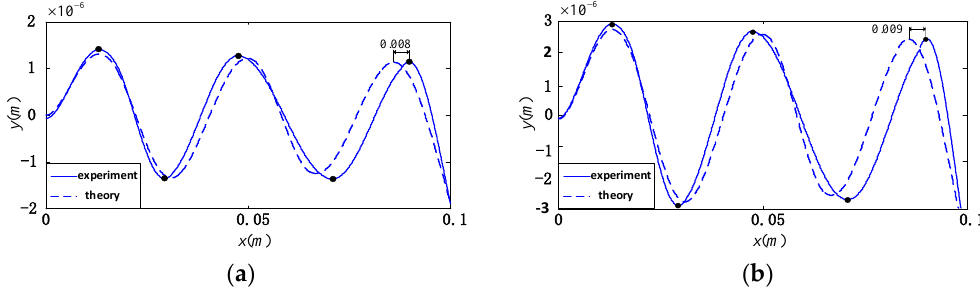
Figure 15. Comparison of theoretical values of forced response and experimental results. ( a ) 100 V excitation voltage; ( b ) 200 V excitation voltage.